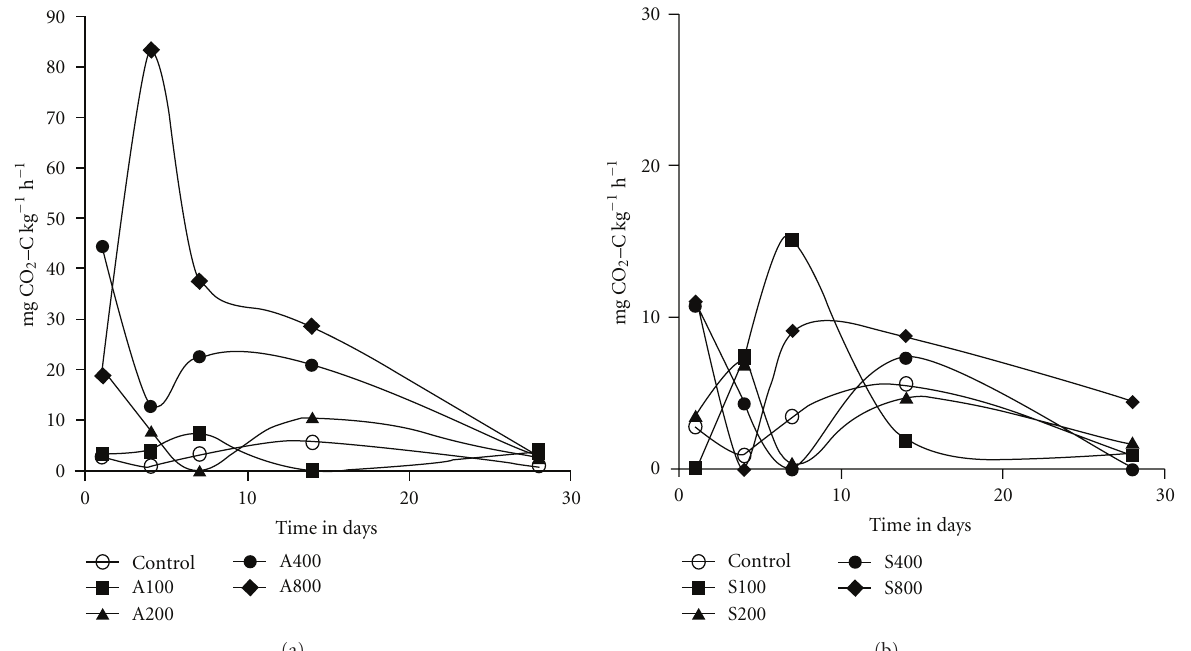
Figure 4: Incubation experiment one. Specific rates of carbon dioxide released from incubation of soil with (a) alfalfa and (b) sludge. Treatment codes refer to amendment rates of alfalfa (A100–A800) and sludge (S100–S800) added in the range 100–800mgNkg − 1 dry soil. 00.511.522.5